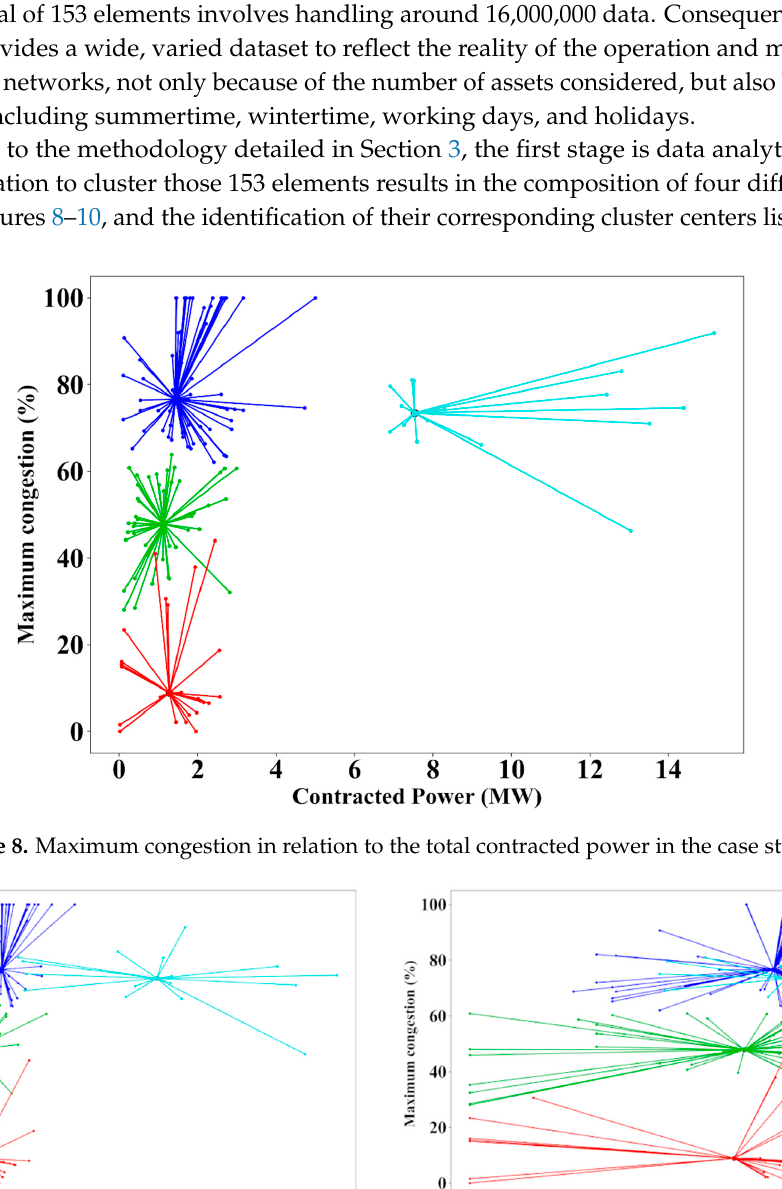
Table 3. Composition of the clusters.